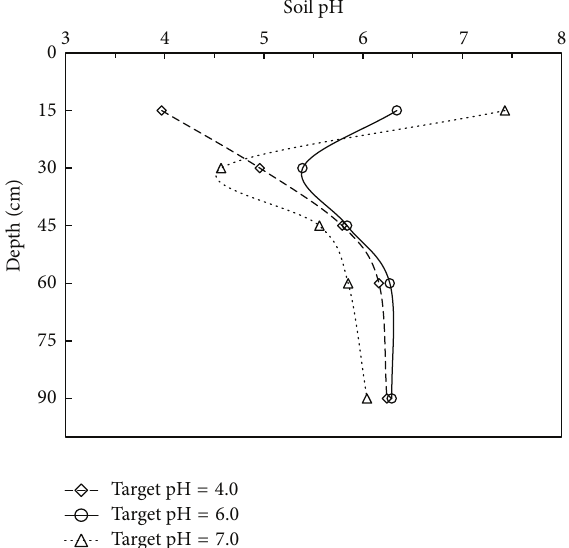
Figure 1: Effect of soil amendments on soil profile pH at Perkins, Oklahoma, in 2010 for target pH of 4.0, 6.0, and 7.0. Initial soil pH on the top 15 cm soil in 2009 prior to soil amendments application was 4.8.